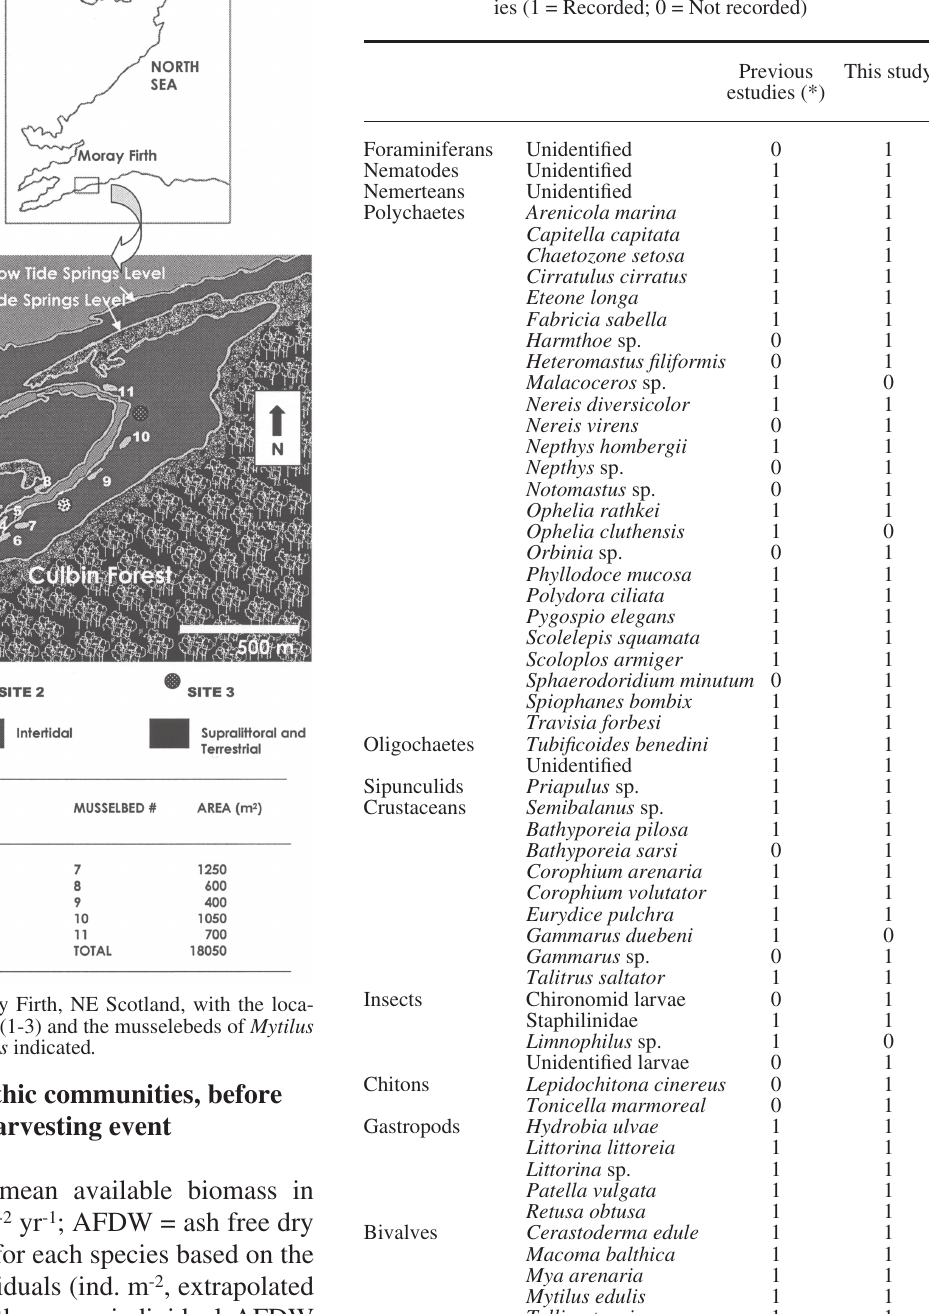
Table 1. – Species checklist for benthic invertebrate macrofauna at Culbin Sands lagoon, NE Scotland, found in this and previous stud-